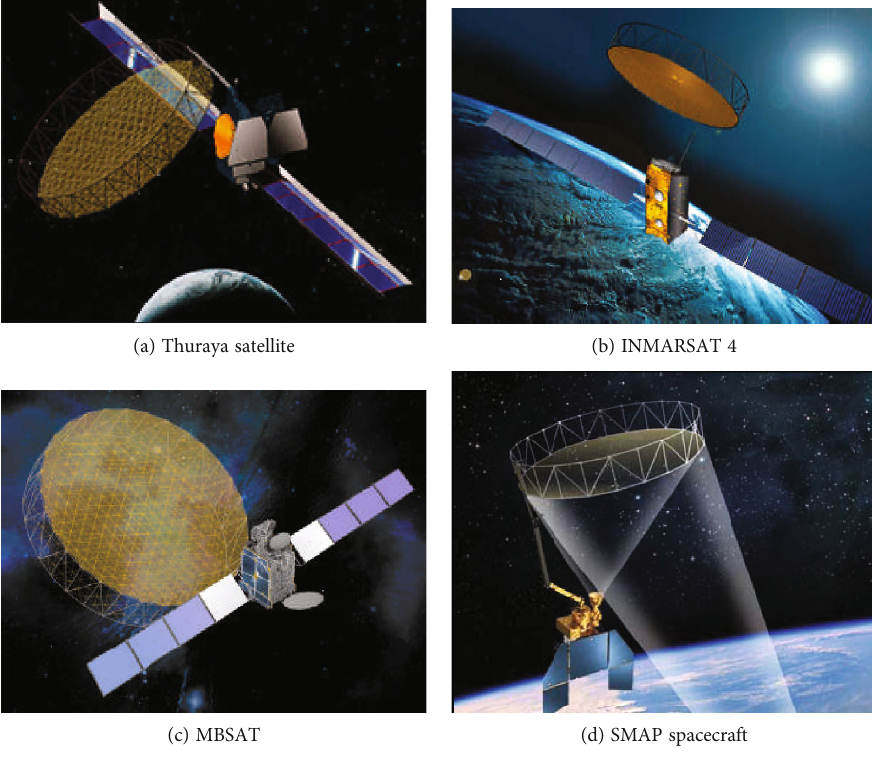
Figure 1: Satellite with ring truss antenna.